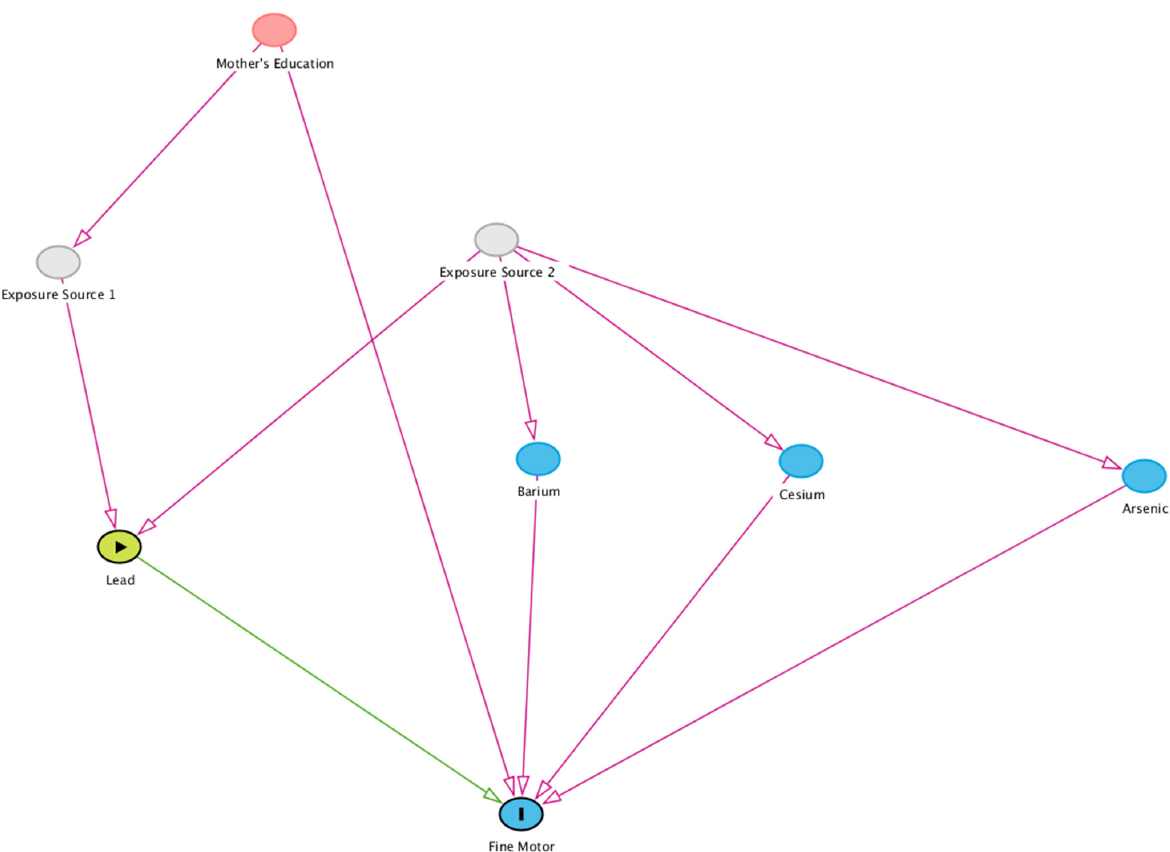
Figure A2. Causal directed acyclic graph for association between lead and fine motor skills.